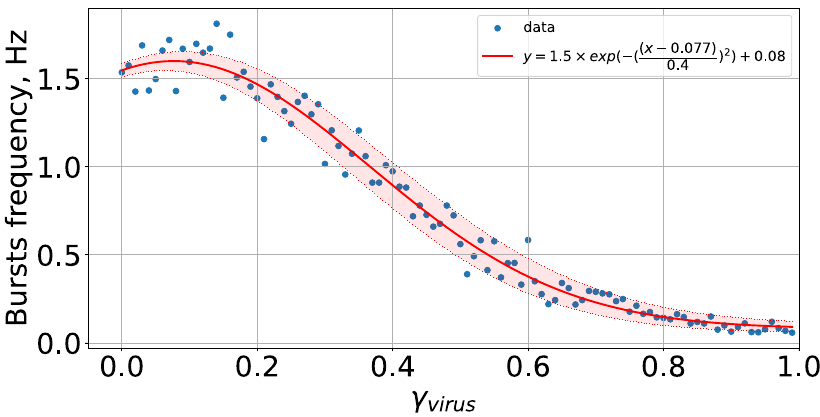
Figure 7. Dependence of bursts frequency from γ virus